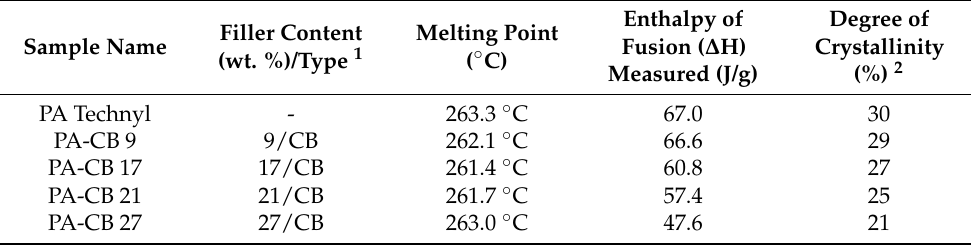
Table 1. Composition, melting point, enthalpy of fusion and degree of crystallinity (%), as obtained from TGA and DSC